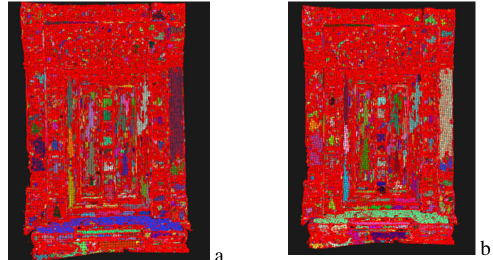
Figure 7. The region growing of the Cambodian portal: Max cluster number 5 (a) and 10k